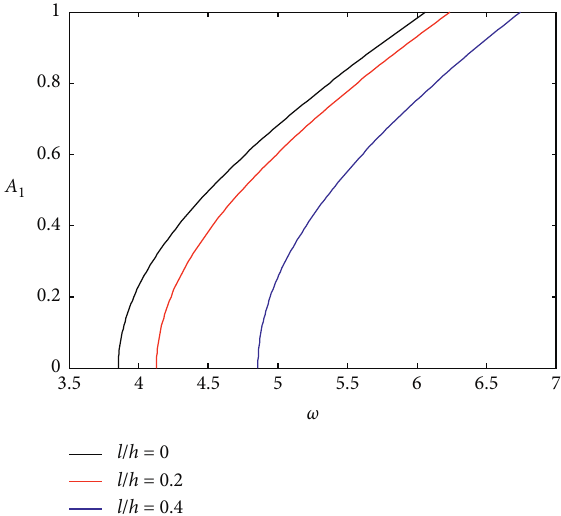
Figure 3: Size effect on frequency-response curves of the